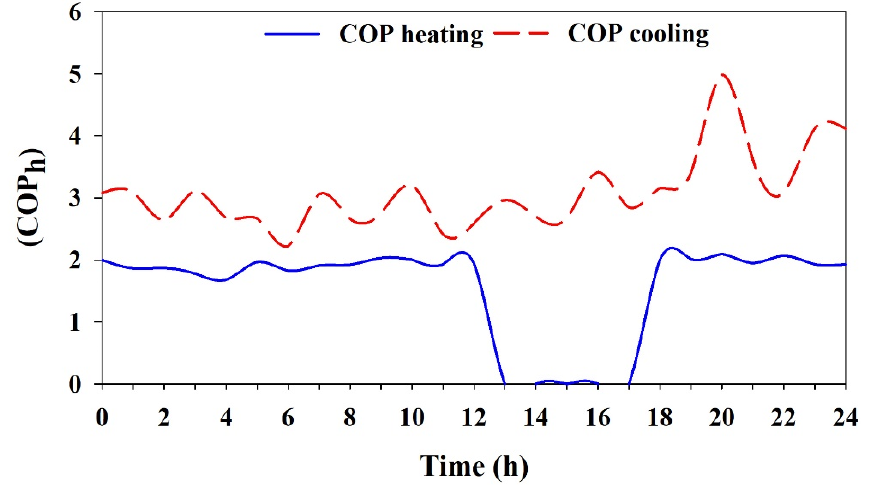
Figure 16. COP of heat pump on heating and cooling mode.